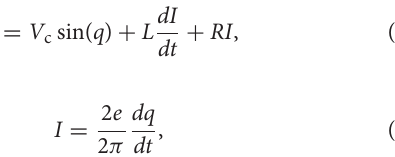
FIGURE 1 | A QPSJ-based IFN circuit that has a firing threshold of N (Cheng et al., 2018 ). V in was 0.8 mV and V b was 1 mV. The V c values used for Q 1 – Q N were 0.7 mV. R b was 9 k (cid:127) . (A) Circuit schematic. (B) Simulation results of an IFN circuit with a threshold of 10. (a) Input voltage. (b) Input current. (c) Output current. (d) Voltage at node